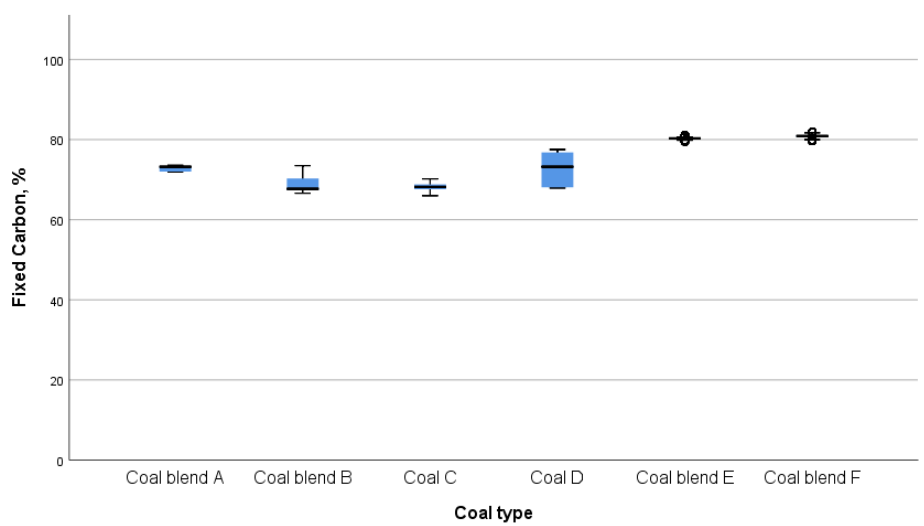
Figure 3. The ranges of the measured ash contents for the oven-dried coals and coal blends used during the study periods (◦ represents outliers) .